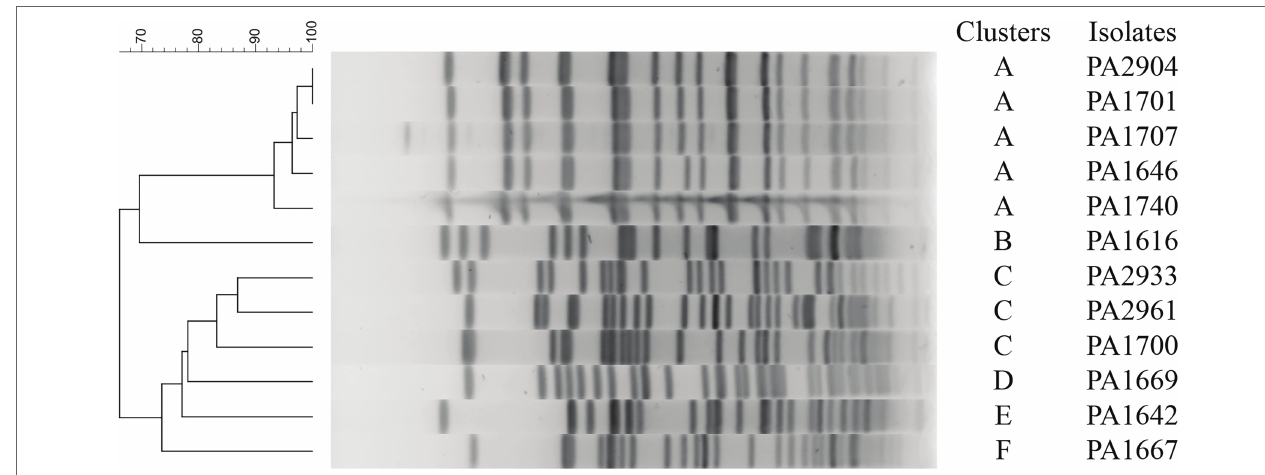
FIGURE 1 | PFGE patterns of 12 bla CARB-3 -positive Pseudomonas aeruginosa